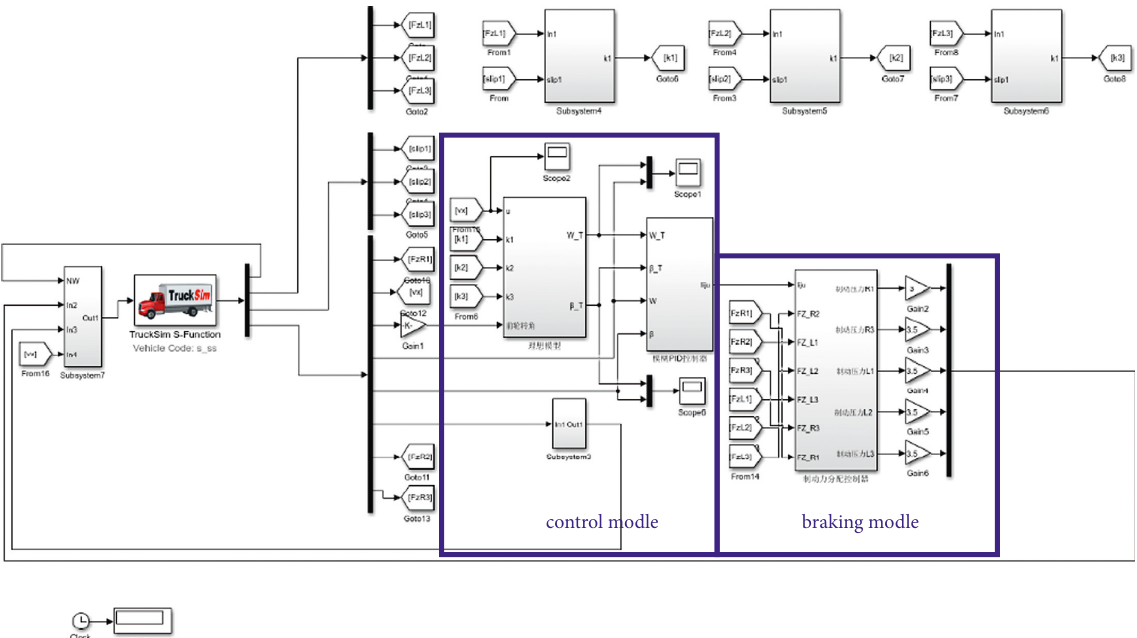
Figure 11: Joint simulation model of vehicle handling stability